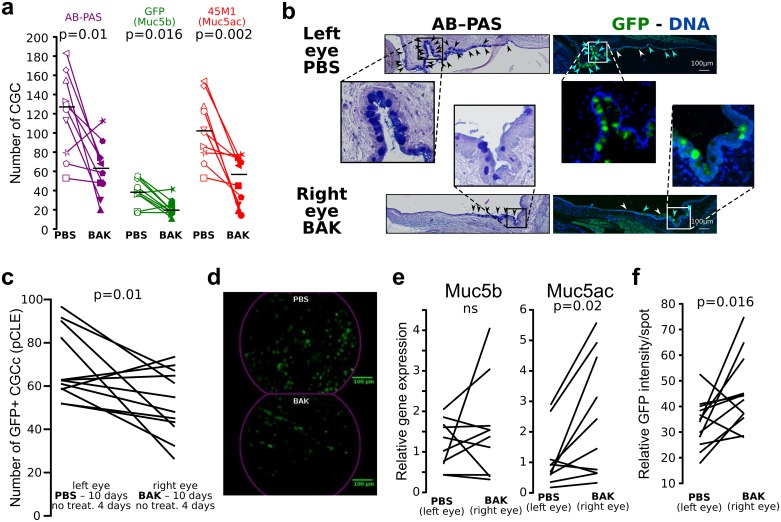
GFP activity is decreased in DES.(a) Scatterplots show that CGC number determined on histological sections (AB—PAS coloration), and GFP+ (Muc5b) and Muc5ac+ CGC number determined by immunofluorescence staining (anti-GFP and anti-Muc5ac antibody) decreased (n = 10 mice, 1 section per mouse, one symbol/mouse) after 10 days of BAK application (filled-in symbols) in one eye (PBS in the other, white-filled symbols) followed by 4 days without any treatment. Horizontal lines indicate median results. (b) Histological and immunofluorescence staining. AB—PAS and serial immunohistochemical section of the left eye, which received PBS, and paired-right eye which received BAK show a decrease in the number of conjunctival goblet cells producing Muc5b (blue arrows) and non-Muc5b producing (white arrows) cells. Black arrows indicate goblet cells. Green signal, anti-GFP antibody. Nuclei (blue) were counterstained with Hoechst 33258. Scale bar, 200 μm. (c) Scatterplot showing that the number of GFP+ CGCc determined by pCLE decreased significantly (n = 12 mice; P = 0.01) after 10 days of BAK application in one eye (PBS in the other) followed by 4 days without any treatment. (d) Illustrative extracted frames of pCLE recorded movies from a conjunctiva after 10 days of PBS application in comparison to 10 days of BAK application followed by 4 days without any treatment. Scale bar, 100 μm. (e) Scatterplots showing the expression levels of the two gel-forming mucins Muc5b and Muc5ac determined by RT-qPCR (TaqMan). No significant (ns) change in gene expression levels of Muc5b was found while Muc5ac was significantly up-regulated after 10 days of topical BAK application (n = 10 extracted RNA/treatment; P = 0.02). (f) Scatterplot showing the integrated fluorescence density per GFP+ CGCc determined by Fiji showing an up-production of Muc5b/CGCc after 10 days of BAK treatment (n = 12 mice; P = 0.016). Statistical significance was assessed using one-sided (a) or two-sided permutation test (a, e, f). ns, P>0.05.